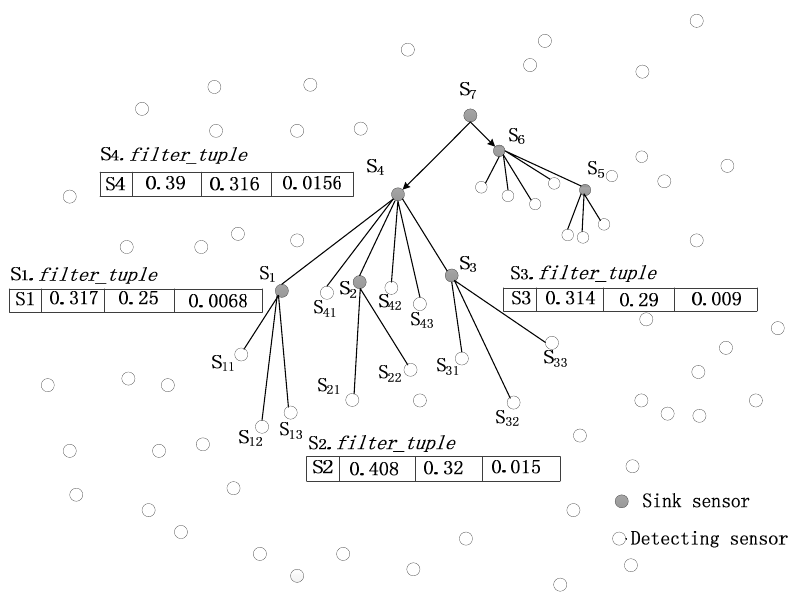
Figure 3. Initialization of the query recycling.